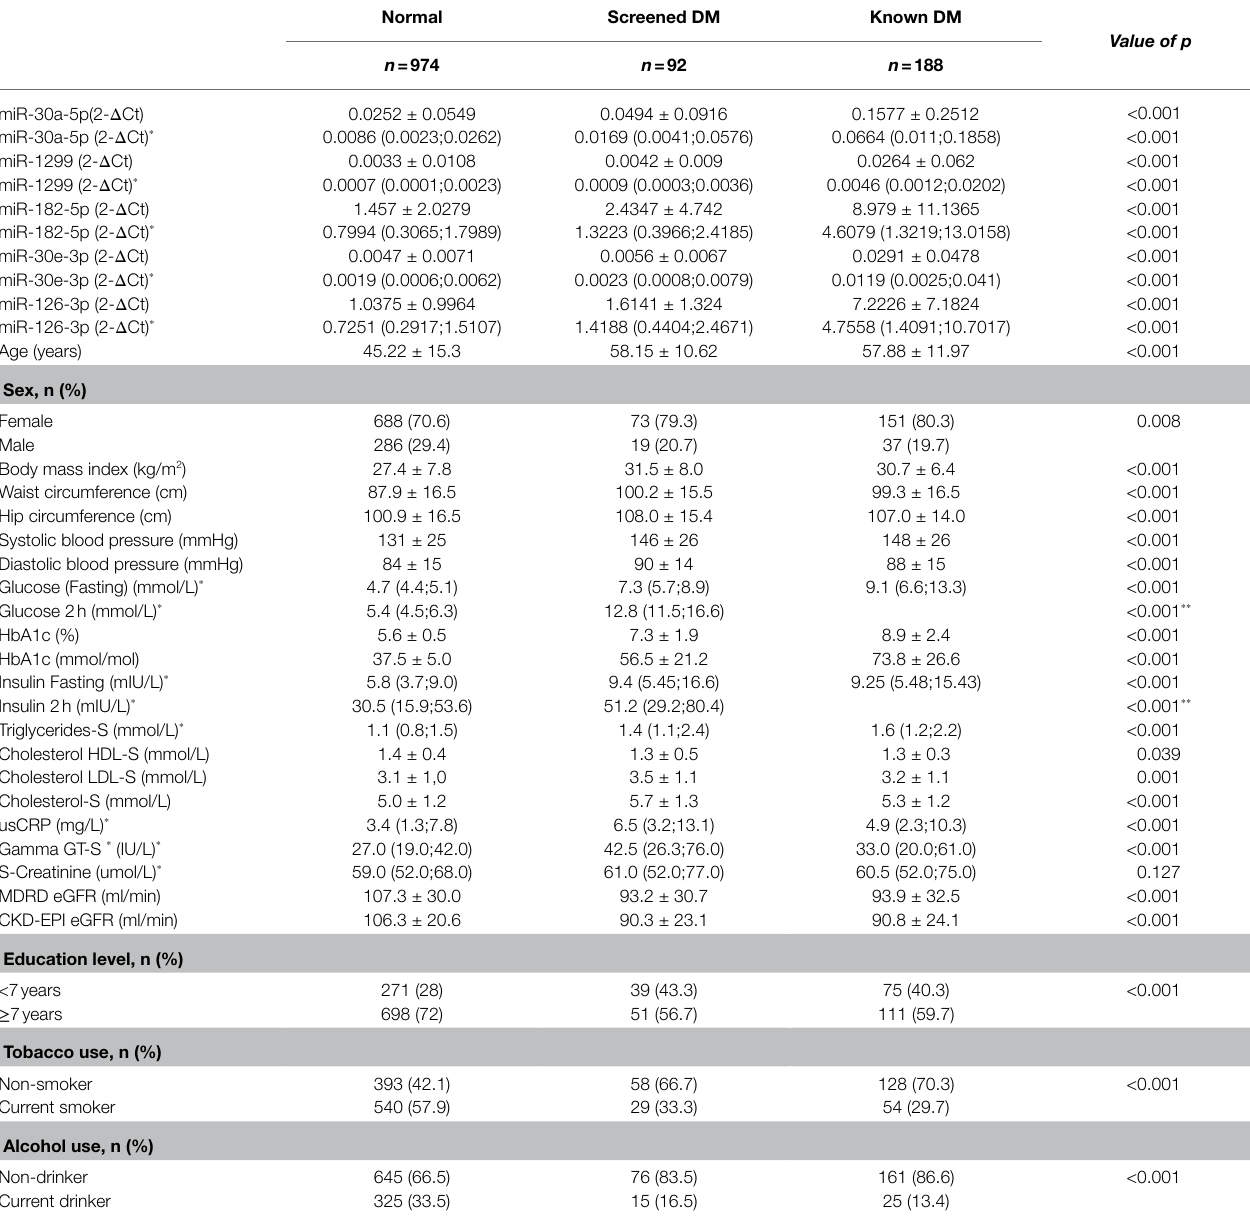
TABLE 1 | Characteristics of participants according to diabetic status. Normal Screened